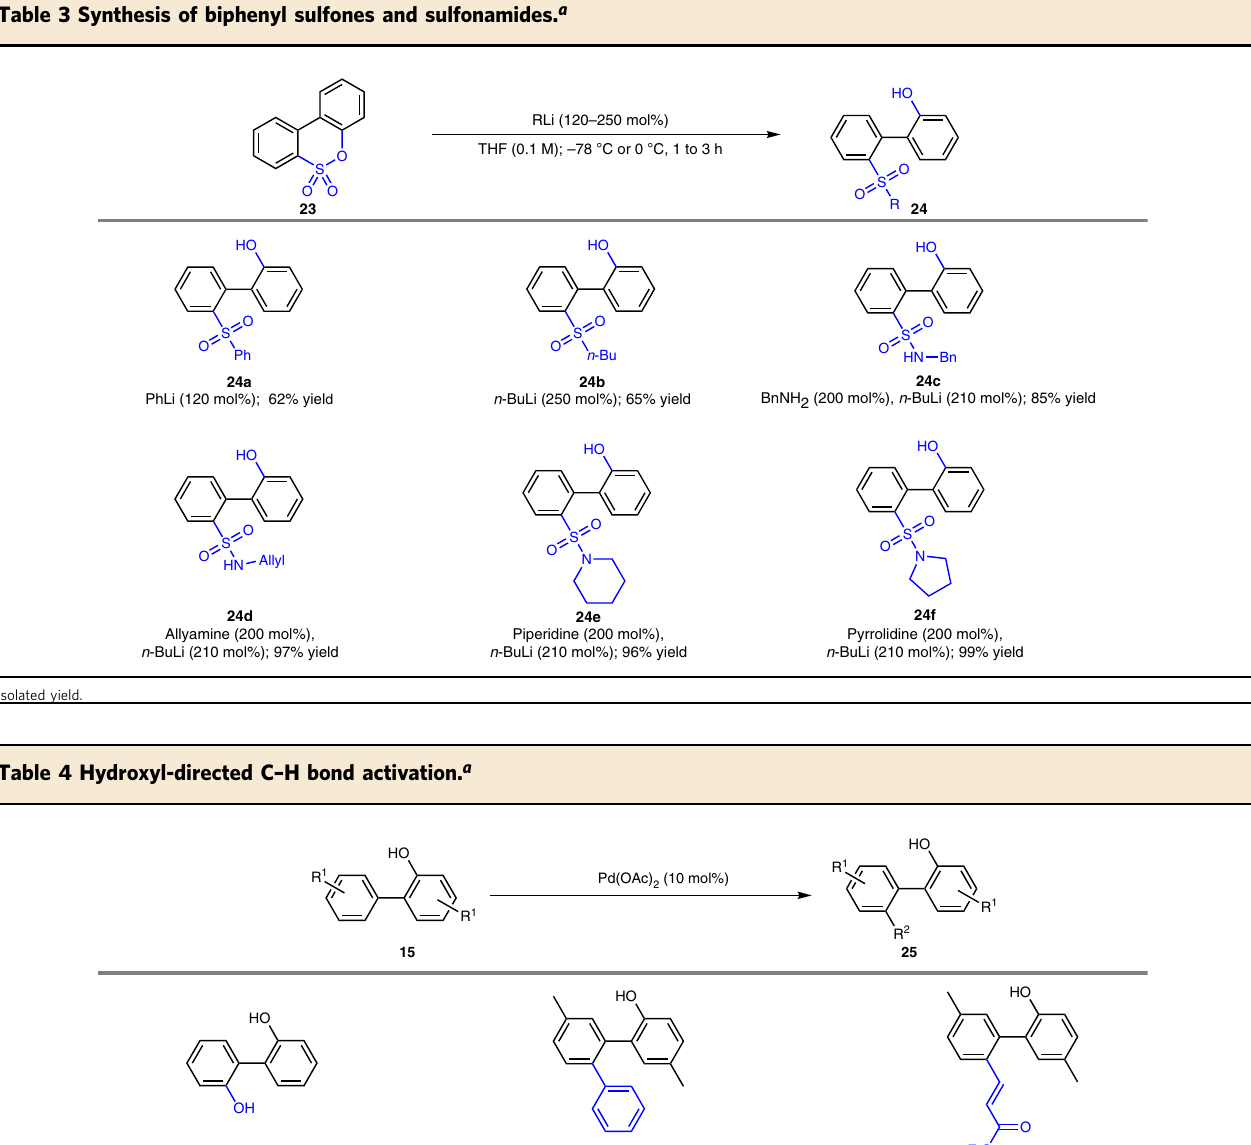
Table 3 Synthesis of biphenyl sulfones and sulfonamides. a